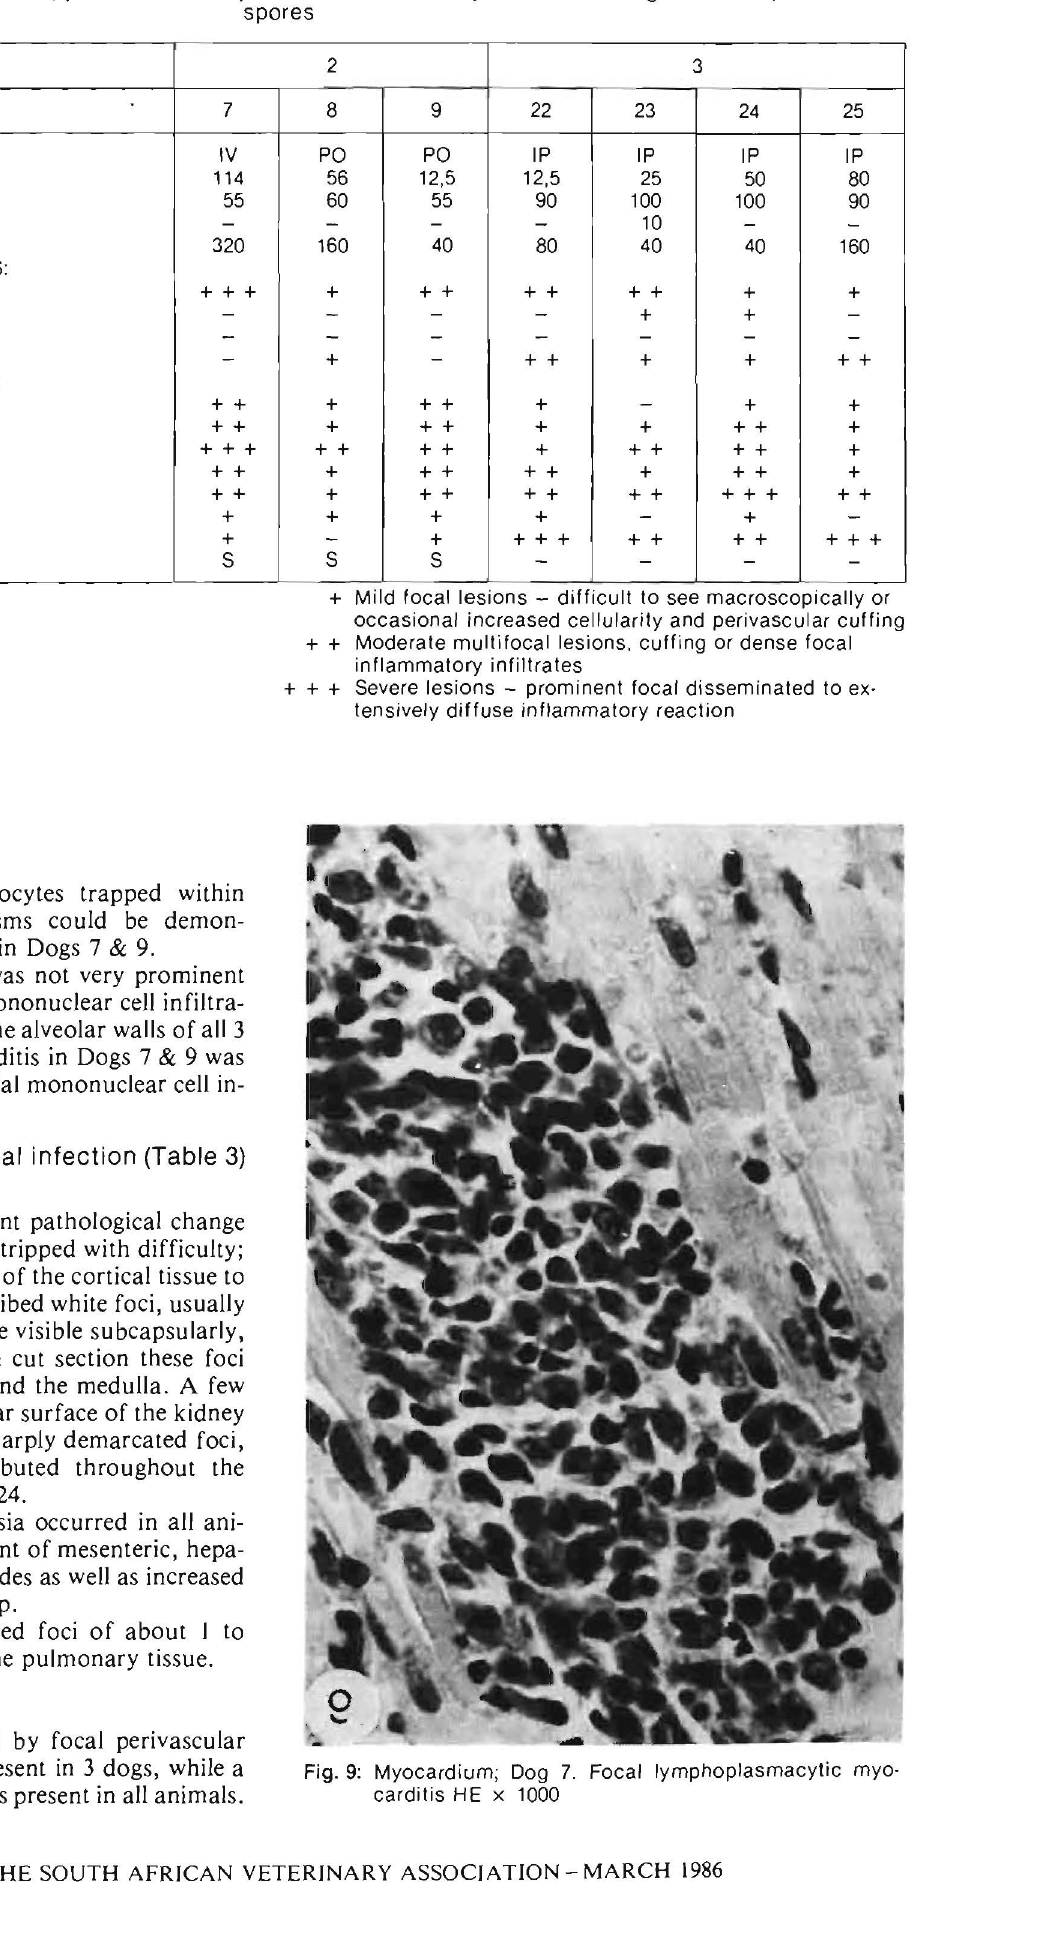
Fig. 9: Myocardium; Dog 7. Focal Iymphoplasmacytic myo carditis HE x